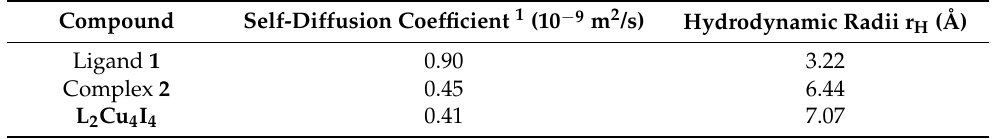
Table 1. The self-diffusion coefficients and hydrodynamic radii of ligand 1 , complex 2 , and reference L 2 Cu 4 I 4